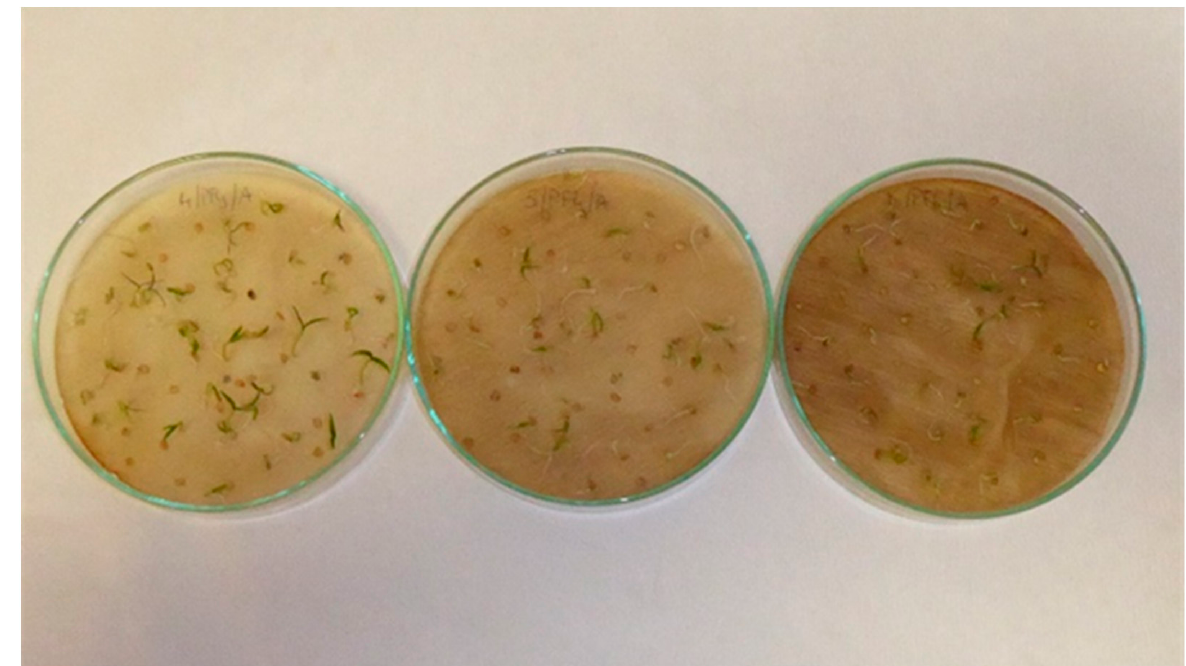
Figure A2. Pepper ( Capsicum anuum L.) seedlings; treatments with aqueous extracts of black cumin ( Nigella sativa L.) in 2.5% concentration ( left ), 5% concentration ( middle ) and 10% concentration ( right ).